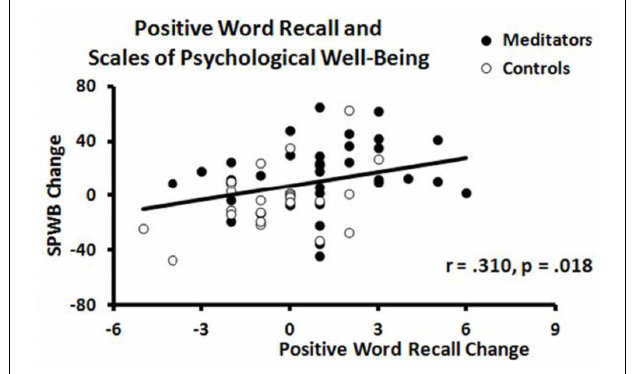
FIGURE 3 | Scatterplot of correlation between changes in positive word recall and changes in psychological well-being scores in meditators (black circle) and controls (open circle).